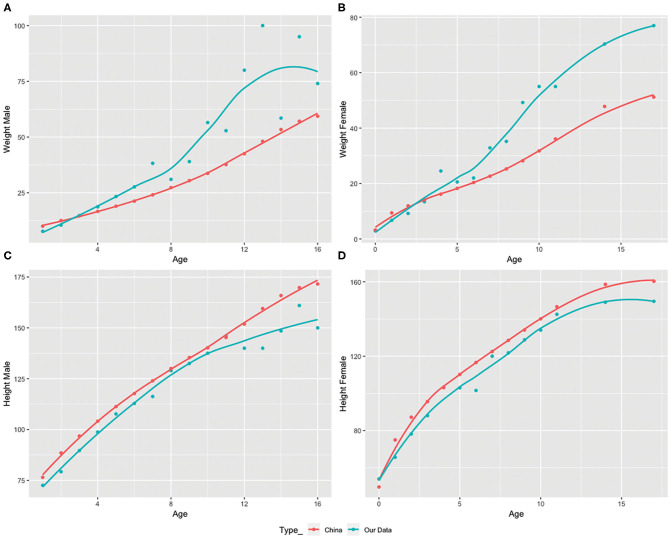
Weight and height variations with age in the study subject population compared to the 50th percentile value according to China's child growth weight standard from age 1 to 16 in males and females provided by the World Health Organization (WHO). (A,B) Comparison of observed and standard 50th percentile weight in males and females by age. (C,D) Comparison of observed and standard 50th percentile height in males and females by age.